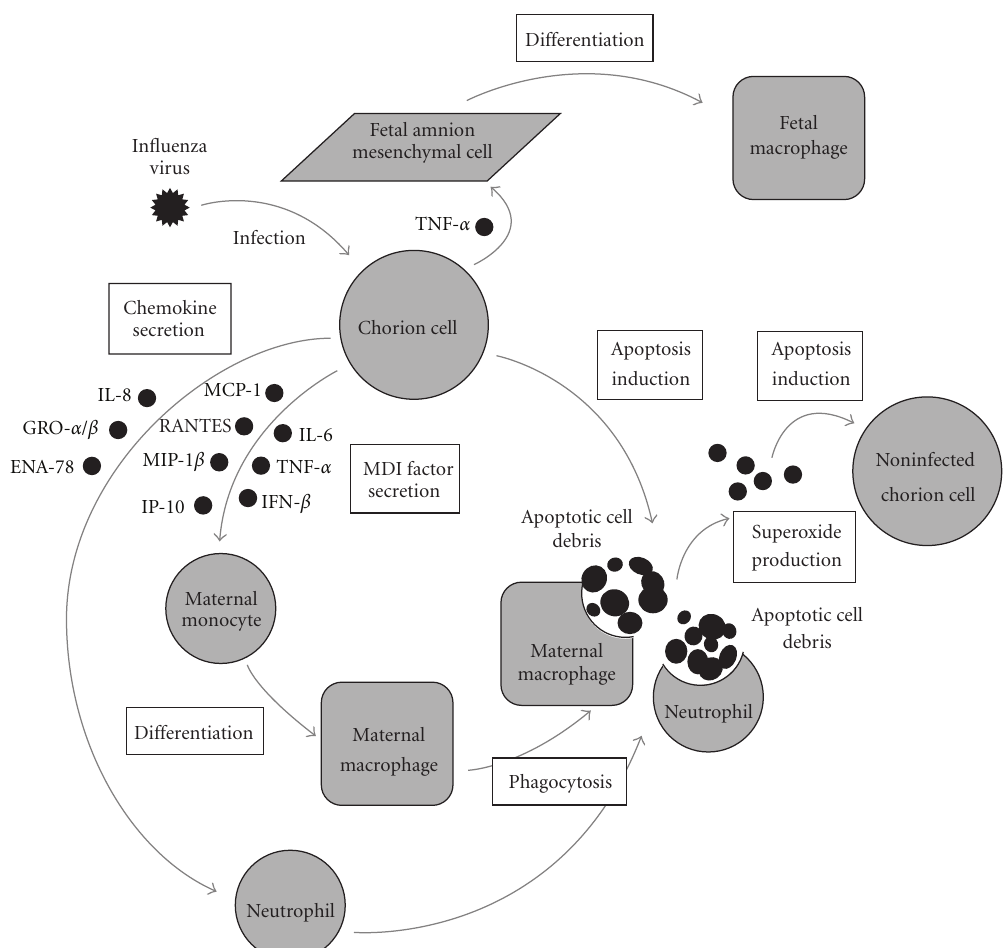
Figure 7: Hypothetical tissue injury model with special emphases of the interaction between human fetal membrane chorion cells and two types of phagocytes. Influenza virus infection induces apoptosis and the gene expression of the MDI factor (i.e., IL-6, TNF- α and IFN- β ), monocyte-attractive chemokines (MCP-1, RANTES, MIP-1 β and IP-10) and neutrophil-attractive chemokines (IL-8, GRO- α / β and ENA-78) in human fetal membrane chorion cells. The monocyte- and neutrophil-attractive chemokines recruit maternal monocytes and neutrophils circulating in the bloodstream into the infected region, respectively. The MDI factor (i.e., IL-6, TNF- α and IFN- β ) di ff erentiates the recruited maternal monocytes and the staying fetal amnion mesenchymal cells to mature macrophages. The mature macrophages and neutrophils phagocytose the apoptotic cell debris of chorion cells resulting from apoptosis. Subsequent to phagocytosis, an abrupt increase in superoxide production by macrophages and neutrophils, known as the oxidative burst, occurs, which is catalyzed by NADPH oxidase enzyme complex. Superoxide produced by phagocytes engulfing chorion cells undergoing apoptosis may injure tissues through inducing apoptosis in noninfected cells in vivo situation, resulting in the formation of necrotic foci. Abbreviations used: ENA-78, epithelial cell- derived neutrophil-activating protein 78; GRO- α / β , growth-related oncogene α / β ; IL, interleukin; IP-10, interferon inducible protein 10; MCP-1, monocyte chemoattractant protein 1; MDI, monocyte di ff erentiation-inducing; MIP-1 β , macrophage inflammatory protein 1 β ; NADPH, nicotinamide adenine dinucleotide phosphate; RANTES, regulated on activation, normal T cell expressed and